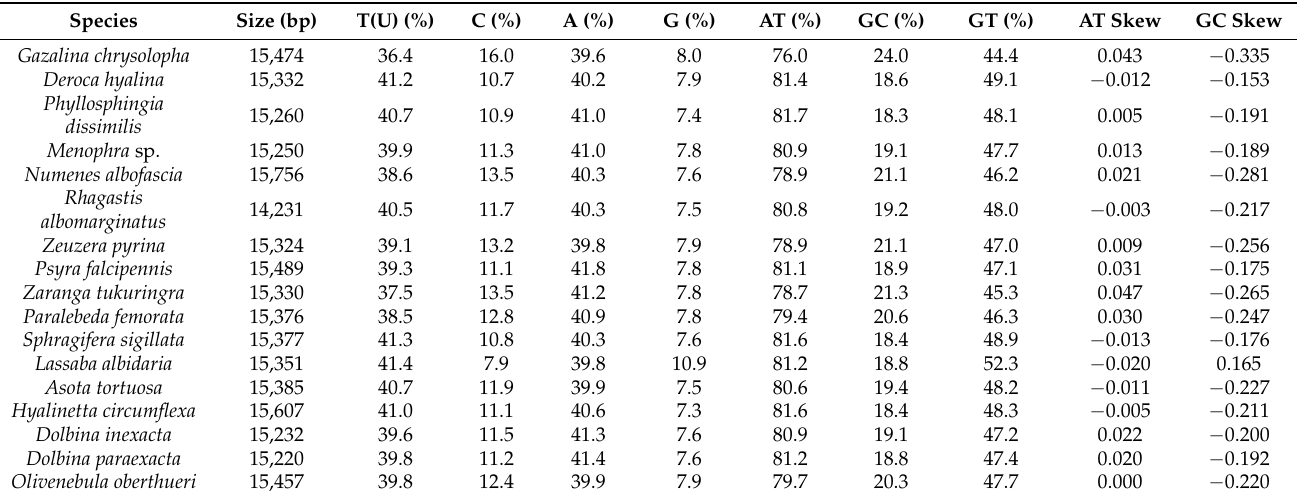
Table 2. The nucleotide composition of 17